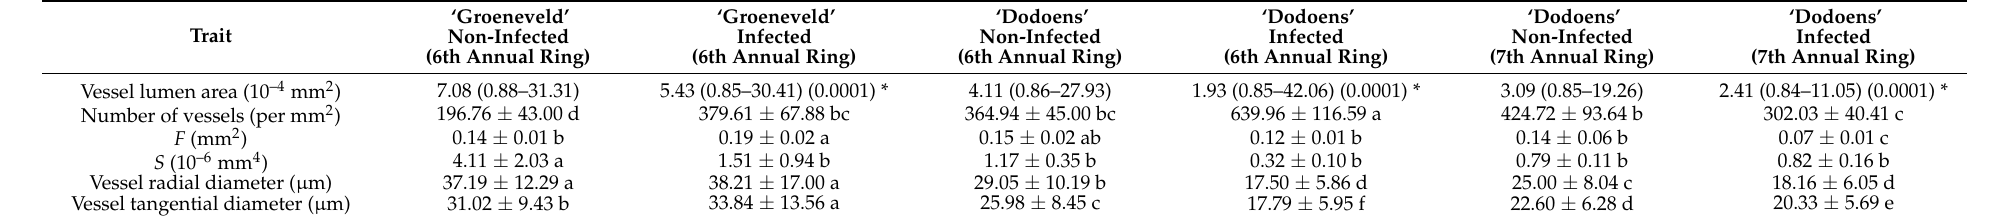
Data represent means ± SD . Mean values followed by the same letters, a–d within the same row across hybrids, are not significantly different at P < 0.05. Table 3. Latewood vascular anatomy in the examined Dutch elm